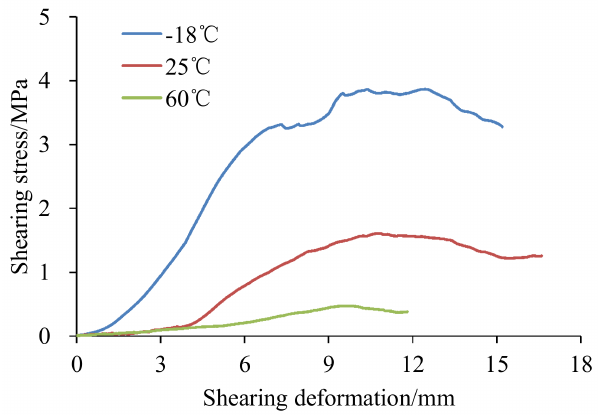
Figure 9. Stress-deformation curves of PPM-10 + AC-20 composite specimens with 0.5 mm SBS modified asphalt adhesive layer at different temperatures.